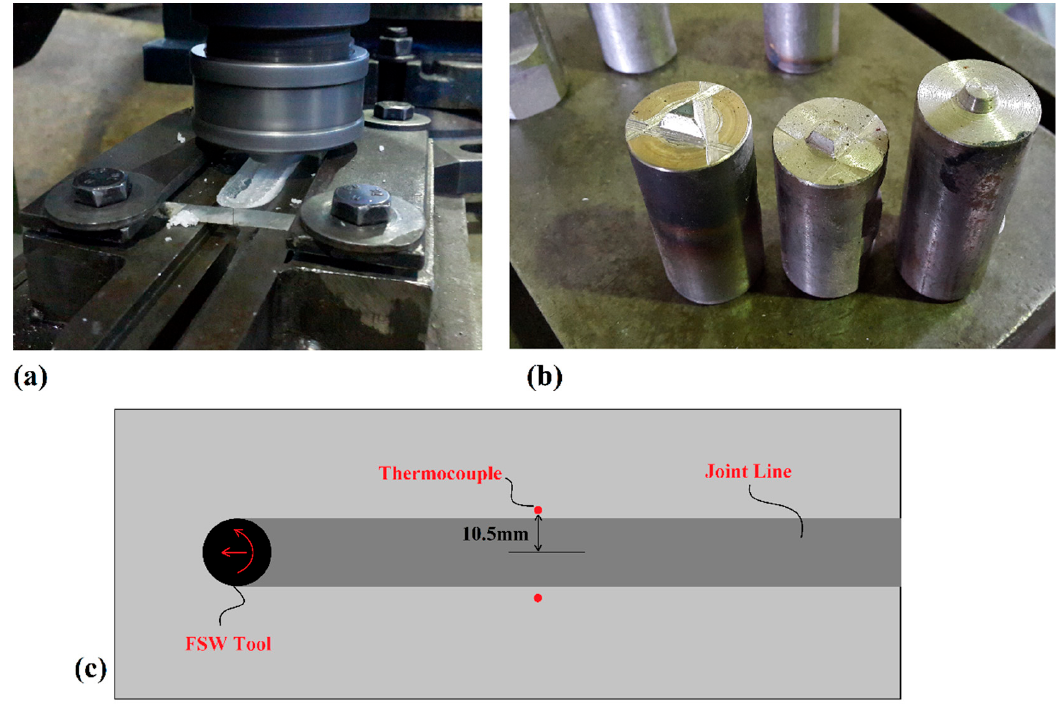
Figure 4. ( a ) FSW setup and joining process, ( b ) FSW tools, ( c ) Thermocouple placements.